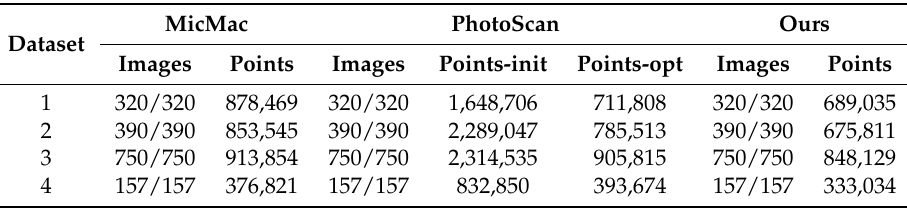
Table 8. The numbers of connected images and 3D points for completeness comparison.